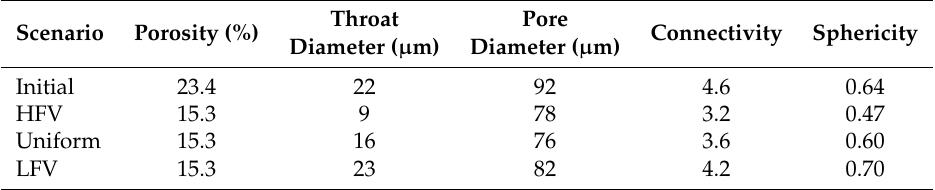
Table 2. Morphological parameters of the initial pore space compared to the microstructures altered by the three spatial precipitation patterns (HFV, uniform and